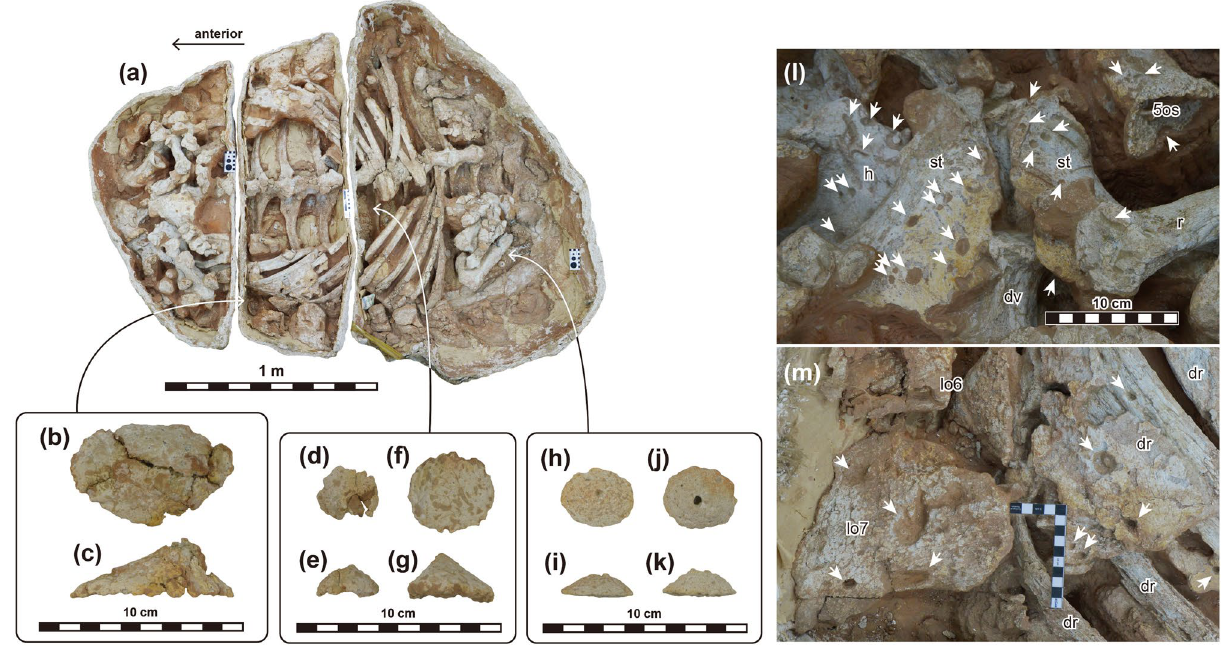
Figure 3. Selected osteoderms ( a – k ) and feeding traces of dermestid beetles ( l and m ). ( a ) MPC-D 100/1359 in ventral view. Arrows indicate the areas where the selected osteoderms were collected. ( b and c ) Type 7 osteoderm in lateral ( b ) and dorsal ( c ) views. ( d – k ) Type 4 osteoderms in lateral ( d , f , h , j ) and dorsal ( e , f , i , k ) views. ( l ) Close up photo of sternal plates. ( m ) Close up photo of the right lateral edge of the middle portion of the trunk. White arrows mark feeding traces. Abbreviations: 5os, Type 5 osteoderm; dr, dorsal rib; dv, dorsal vertebra; h, humerus; lo, lateral osteoderm; r, tebrae. Nine fused posterior dorsal vertebrae from the sixth to 14th are also fused with their ribs to form a long presacral rod. The dorsal ribs increase progressively in size posteriorly from the first to the 11th. These ribs each have a horizontally expanded, flat dorsal surface with a ventrally deep head, which gives the rib a T- or L-shaped proximal cross-section. These ribs also have irregular plate-like bony processes that extend posteriorly from the mid-shaft regions. The processes overlap the lateral surfaces of up to three following ribs. In the third to sixth dorsal ribs, these processes are co-ossified to each other, forming a large lateral plate. The 12th to 14th dorsal ribs are rod-like and smaller and anteroposteriorly narrower than the 11th dorsal ribs. A parasacral rib ( sensu 16 ) is present posterior to the 14th dorsal ribs. These are also slender, similar to the 12th to 14th dorsal ribs, and the lateral portion is posteriorly arched where it contacted the ilium posterolaterally. The most anterior sacral rib is preserved on the right side only. This robust rib is horizontal and fused laterally to the ilium. Only the left scapula and coracoid are preserved, and a suture line is observable between the two bones (Fig. 2). Although the preserved scapula is fragmentary, the coracoid is moderately complete. A hook-like ster- nal process is present on the ventral margin of the coracoid. The coracoid foramen is located near the glenoid fossa, which faces posterolaterally and is separated by an open suture from the scapula. The unfused sternal plates are large and triangular. The hourglass-shaped humeri are short and robust, and in each the maximum proximal width is about 50% that of the total length. The deltopectoral crest extends distally to about the middle of the humerus and has a lateral process on the proximal edge, which can be observed on the left side. The crest extends more laterally than anteriorly. The humeral shaft is short and thick. Both rod-like radii are present. The expanded proximal and distal condyles of the radius are similar in size. Both robust ulnae are also preserved and each has a blunt olecranon. The medial process of the ulna is prominent. Five metacarpals are preserved in a shallow arc on both sides. All metacarpals are robust, with expanded proximal articular surfaces and distal condyles. Metacarpals I to IV are similar in size, but metacarpal V is smaller. Five proximal phalanges (I-1 to V-1) are present on the right manus, but only the first proximal phalanx (I-1) is preserved of the left manus. The phalanges are wider distally than proximally. An undistorted right ilium is preserved, which diverges at an angle of around 28° from the midline of the body (Fig. 2). It is long with a blade-like preacetabular process extending anterolaterally. The closed acetabulum is level with the medially positioned first sacral rib. A short buttress-like postacetabular process extends posterolaterally from the acetabulum. The femur is uncrushed but only preserved with posteriorly expanded distal condyles, of which the lateral condyle projects more ventrally than the medial one. The stout tibiae are straight, and each has an anteroposteriorly expanded proximal condyle. Both of the long and narrow fibulae are preserved, although the distal portion of the right one is missing. They are straight or slightly curved. Left metatarsals II to IV, and right metatarsals II and III are preserved. They are elongate and somewhat hour-glass shaped. Metatarsal III is only slightly longer than metatarsals II and IV. Pedal phalanges II-1 to -3, III-1, and IV-1 to -3 are preserved on the left side, whereas III-1 to -3 and IV-1 to -3 are present on the right side. The phalangeal count is 0-3-3-3-0.